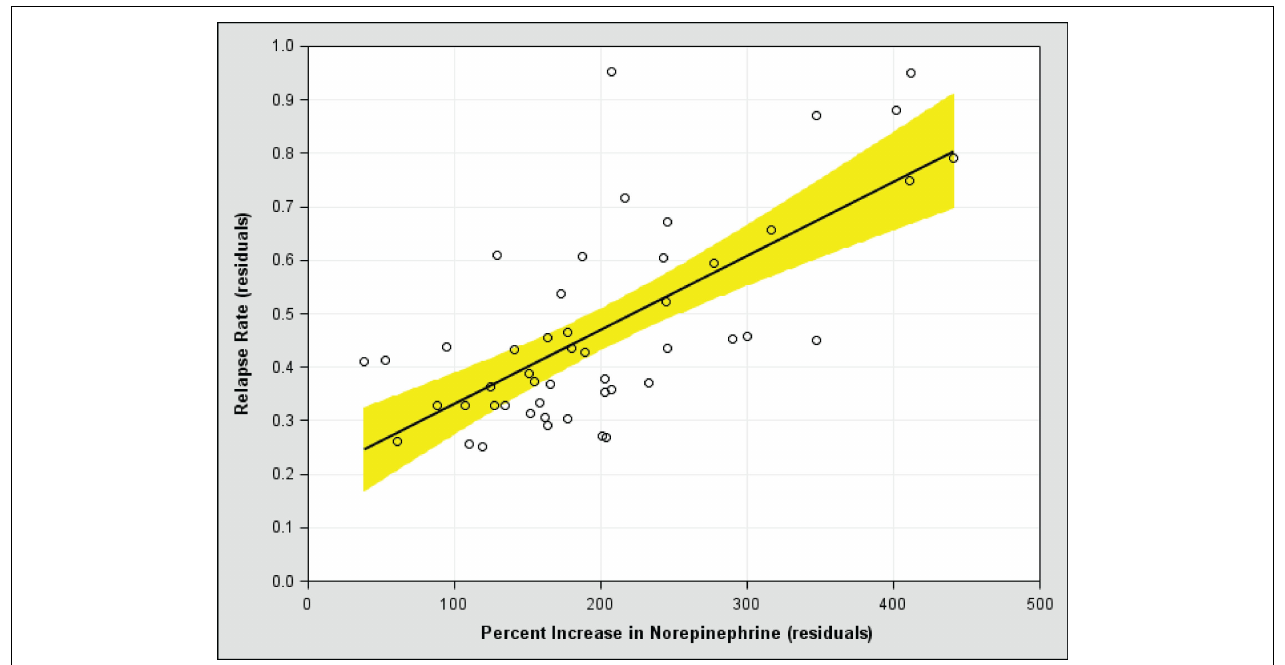
FIGURE 3 |The risk of relapse after antidepressant discontinuation ( y -axis) versus the perturbational effect of antidepressants on norepinephrine in the rodent medial prefrontal cortex ( x -axis), after controlling for covariates. A score of 100 on the x -axis means the antidepressant has no effect on norepinephrine